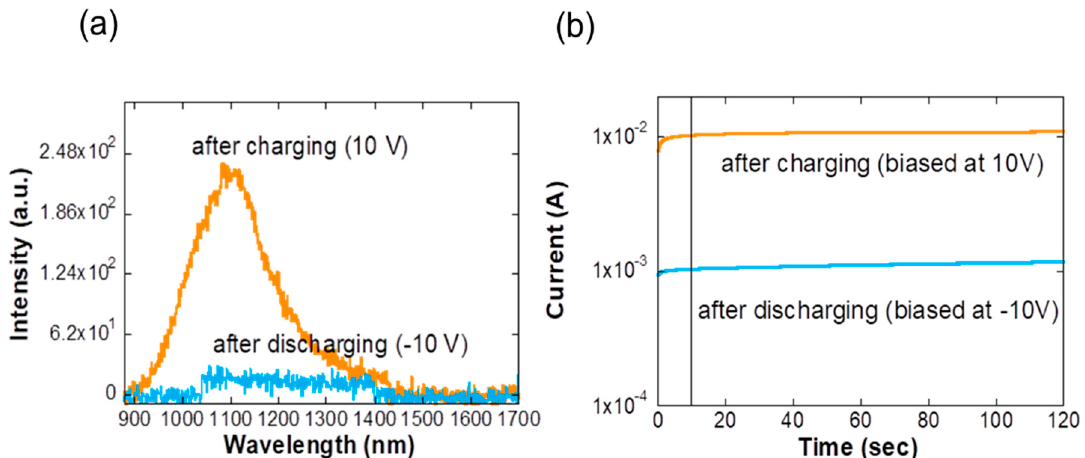
Figure 3. Voltage polarity (+10 V and − 10 V) dependent EL intensity change. EL intensity in ( a ) was measured after application of +10 V and − 10 V. The diode current in ( b ) was measured right immediately after application of +10 V and − 10 V as a function of time under application of 1.5 V.